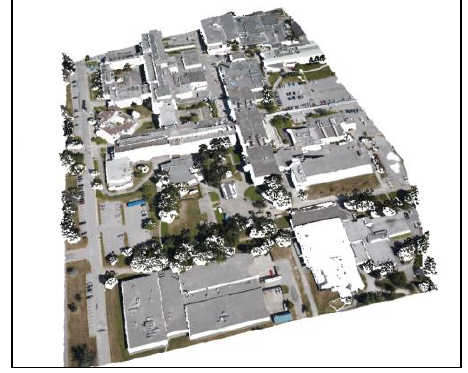
Figure 4: A photo-realistic 3D model generated using region- based texturing